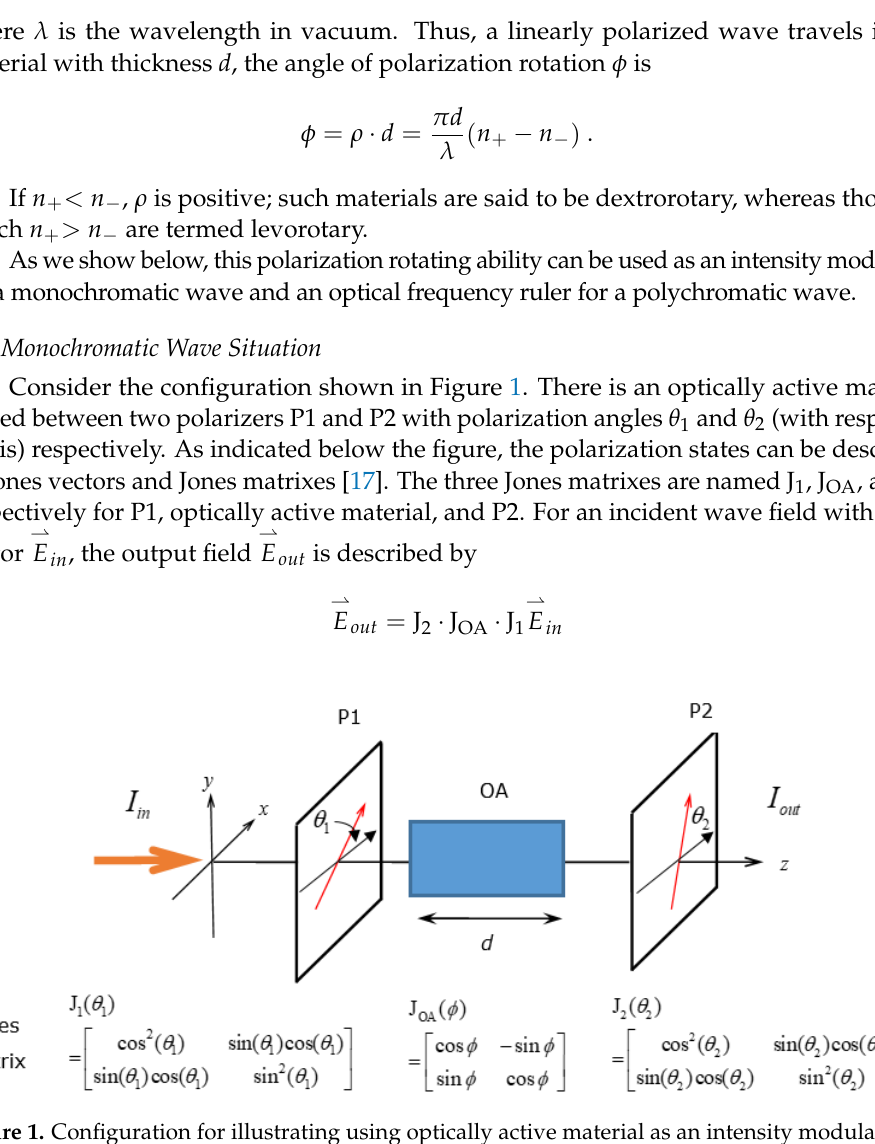
Figure 1. Configuration for illustrating using optically active material as an intensity mod- ulator .